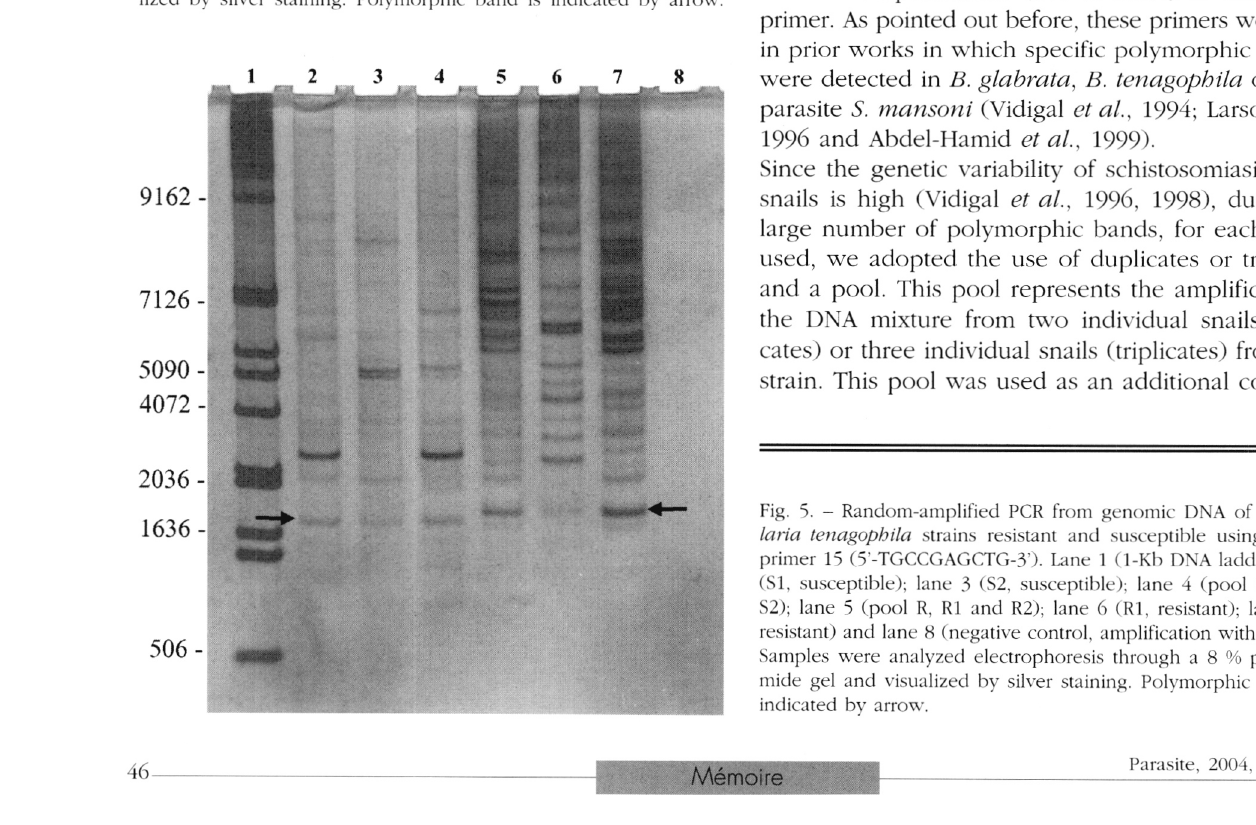
Fig. 3. - Random-amplified PCR from genomic DNA of Biompha­ laria tenagophila strains resistant and susceptible using arbitrary primer 9 (5’-CAGGCCCTTC-3’). Lane 1 (1-Kb DNA Ladder); lane 2 (S1, susceptible); lane 3 (S2, susceptible); lane 4 (S3, susceptible); lane 5 (pool S, S1, S2 and S3); lane 6 (pool R, R1, R2 and R3); lane 7 (R1, resistant); lane 8 (R2, resistant); lane 9 (R3, resistant); lane 10 (negative control, amplification without DNA). Samples were ana­ lyzed electrophoresis through a 8 % polyacrylamide gel and visua­ lized by silver staining. Polymorphic band is indicated by arrow.